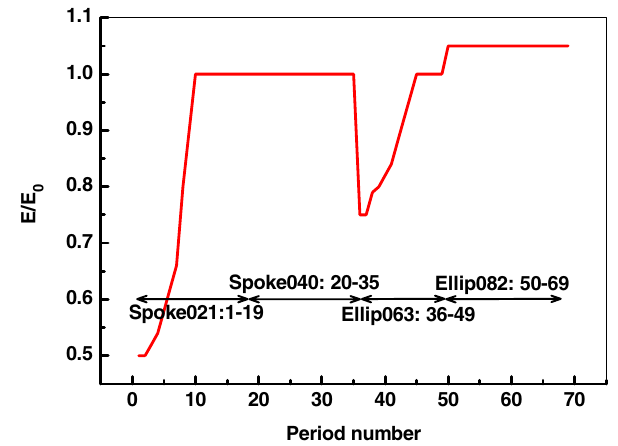
FIG. 17. Effective rf voltages in use for all the cavities as compared with the nominal